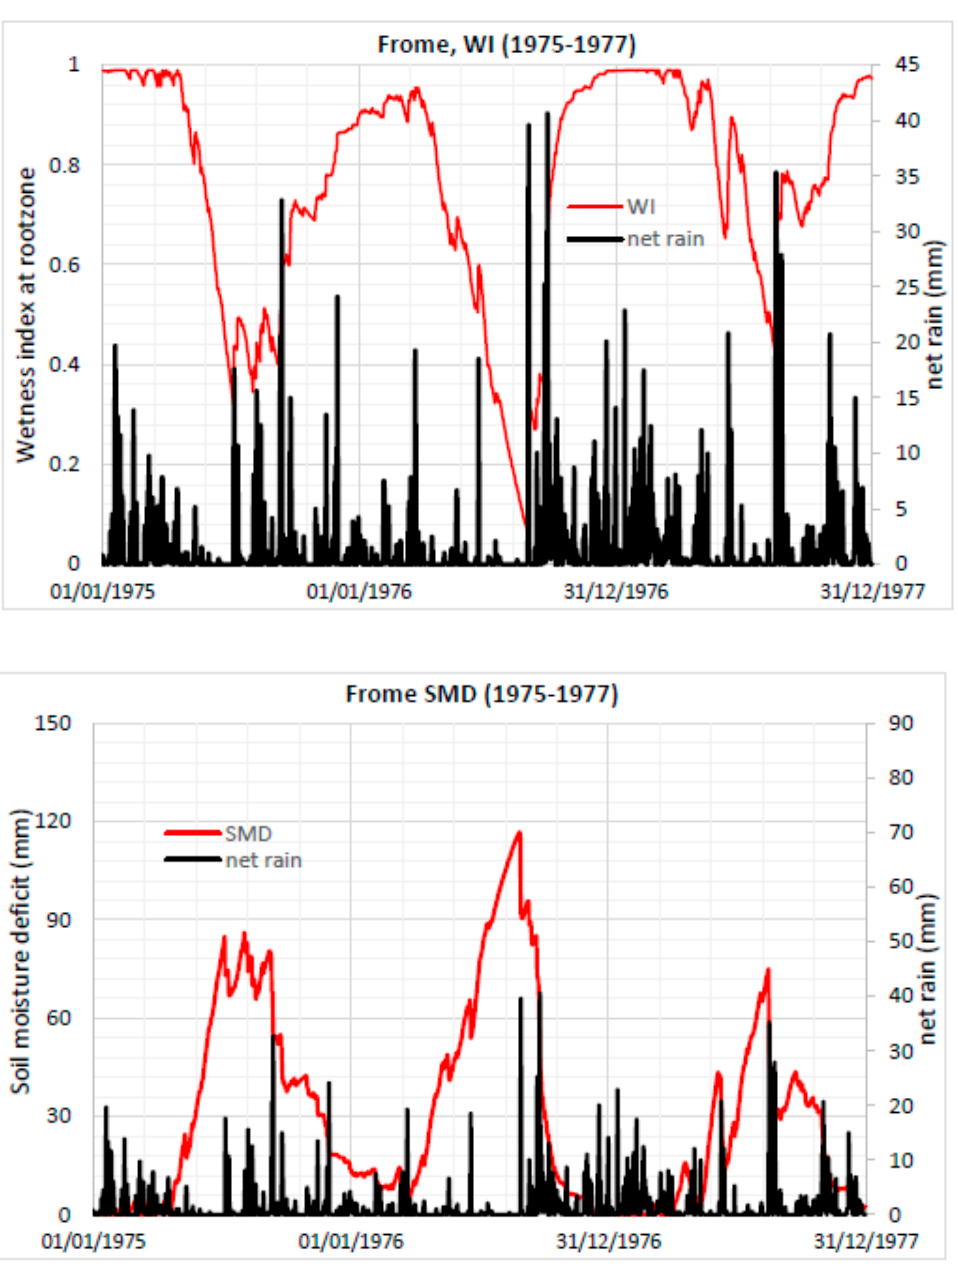
Figure 10. Wetness Index ( top ) and soil moisture deficit ( bottom ) of the root-zone for the Frome catchment during 1975–1977 drought period.